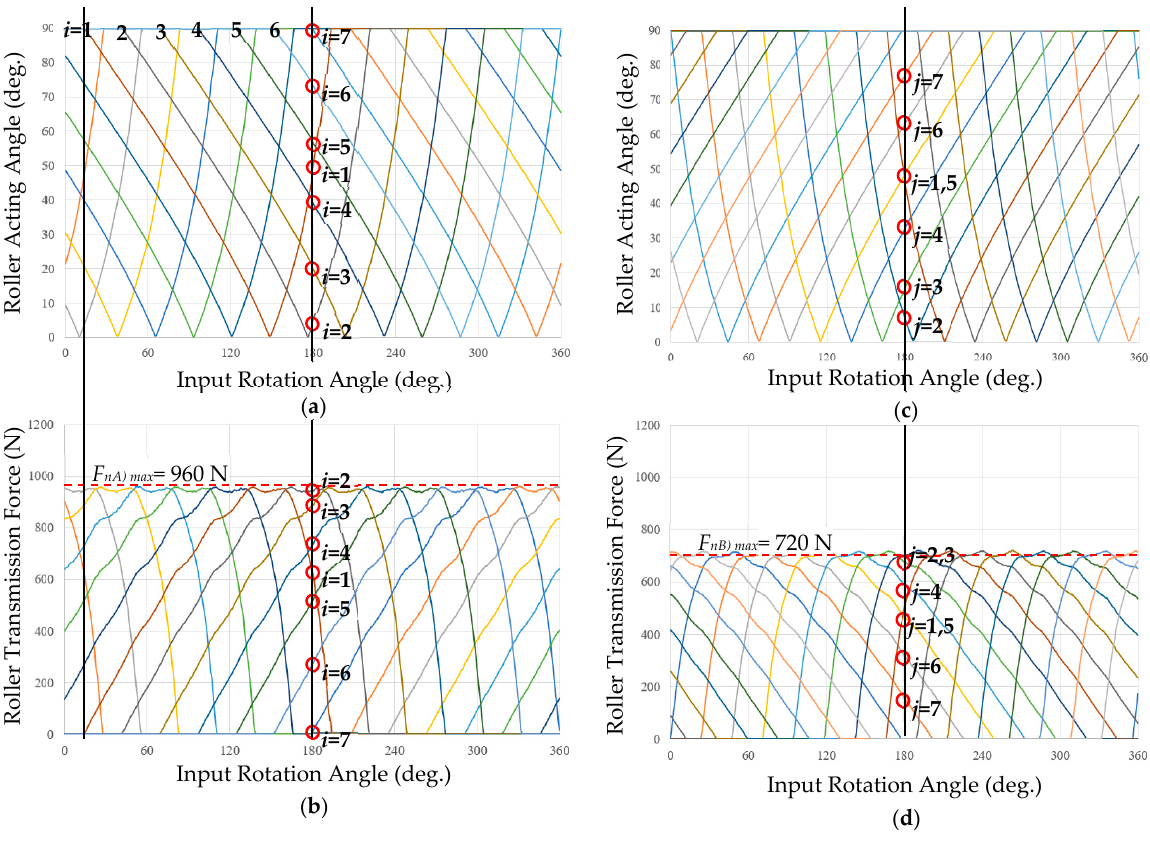
Figure 6. Analysis of the resisting rollers for LCR II: ( a ) the acting angles; ( b ) the transmission forces. Analysis of the actuating rollers for LCR II: ( c ) the acting angles; ( d ) the transmission forces. The contact stress analysis of LCR II for its two lobe cams and their turret rollers